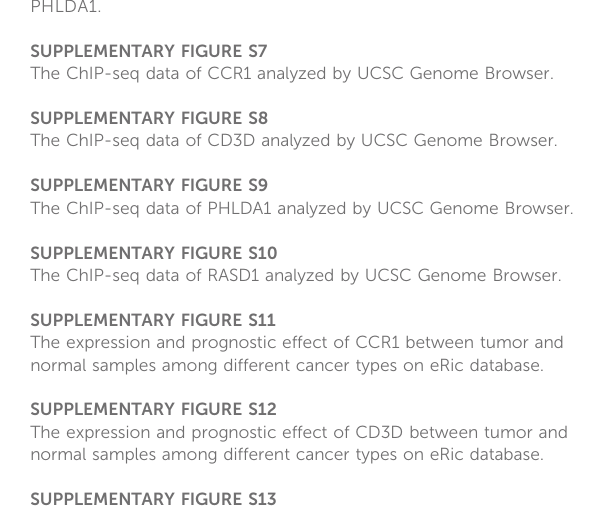
SUPPLEMENTARY FIGURE S1 The schematic diagram of analytic processing. SUPPLEMENTARY FIGURE S2 Cross-validation and model diagnosis of sarcoma. (A) Coef fi cient curves of variables in the prognostic prediction model. (B) The correlation between λ and partial likehood deviance. At the variable number of 13, the partial likehood deviance was lowest. (C) The heatmap of 13 DEeRNAs in all sets, training set, and testing set. (D) The scatter dot plot of all sets, training set, and testing set. (E) The